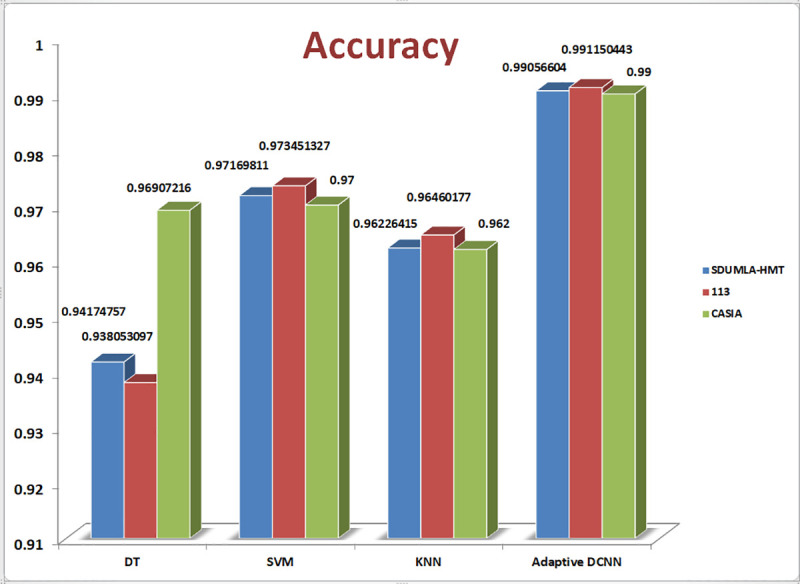
Accuracy of our proposed system and the three comparison systems.